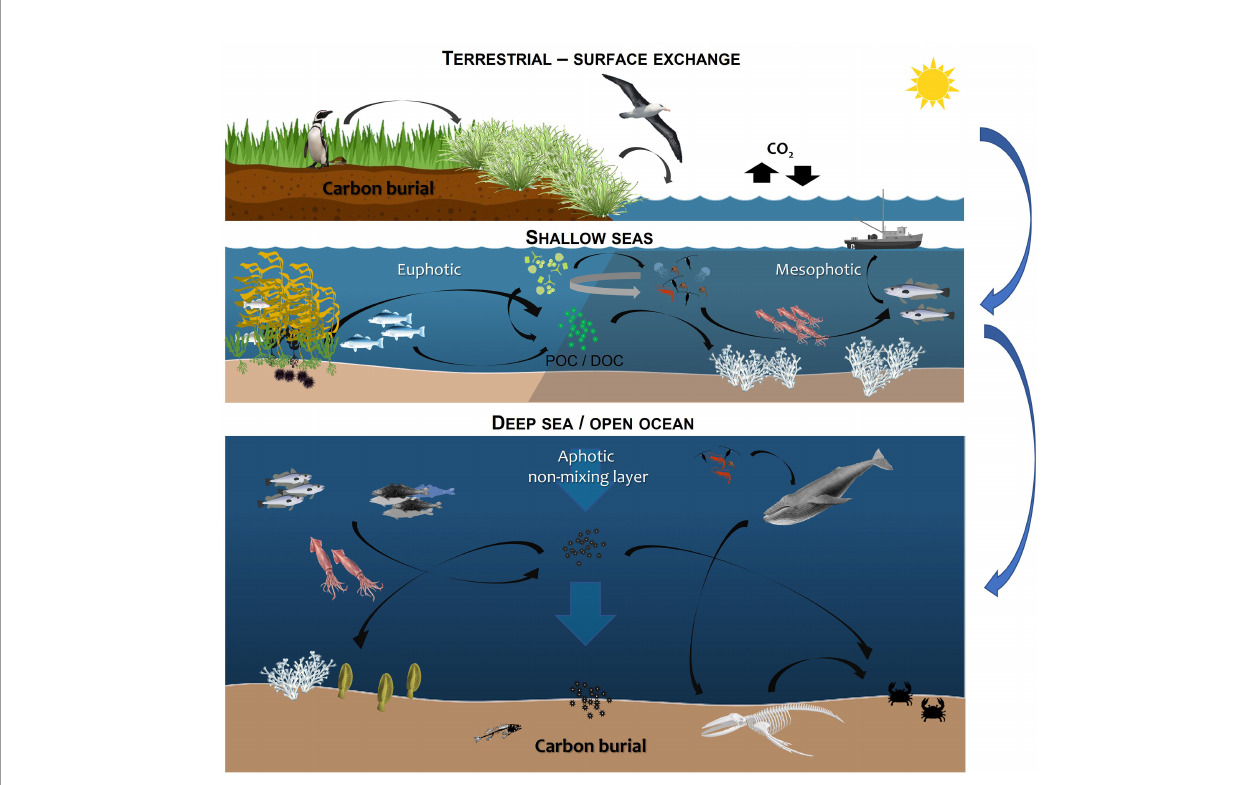
FIGURE 1 | Overview of blue carbon habitats considered here including tidal marsh, mud fl ats and terrestrial input, the mesophotic zone (30 - 150 metres) and sea fl oor (carbon storage and sequestration potential) (see SI for an overview of the habitat data available and limitations of the